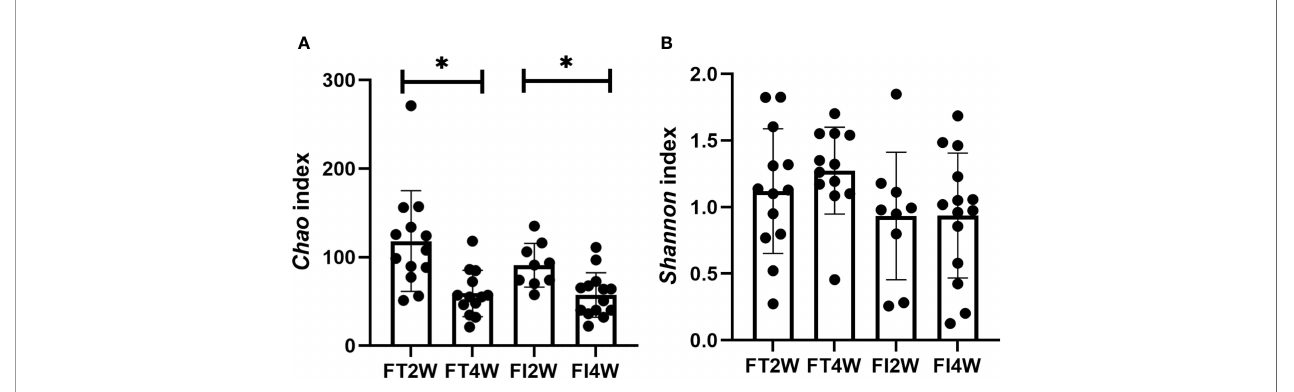
FIGURE 1 | Alpha diversity of the microbiota in the different groups. There were no differences in the Chao index between the two groups at 2 and 4 weeks after birth, and it decreased from 2 to 4 weeks in both the FT and FI groups (A) . There was no difference in the Shannon index between the FI and FT groups or within the FI or FT group at 2 and 4 weeks of life (B) . *: